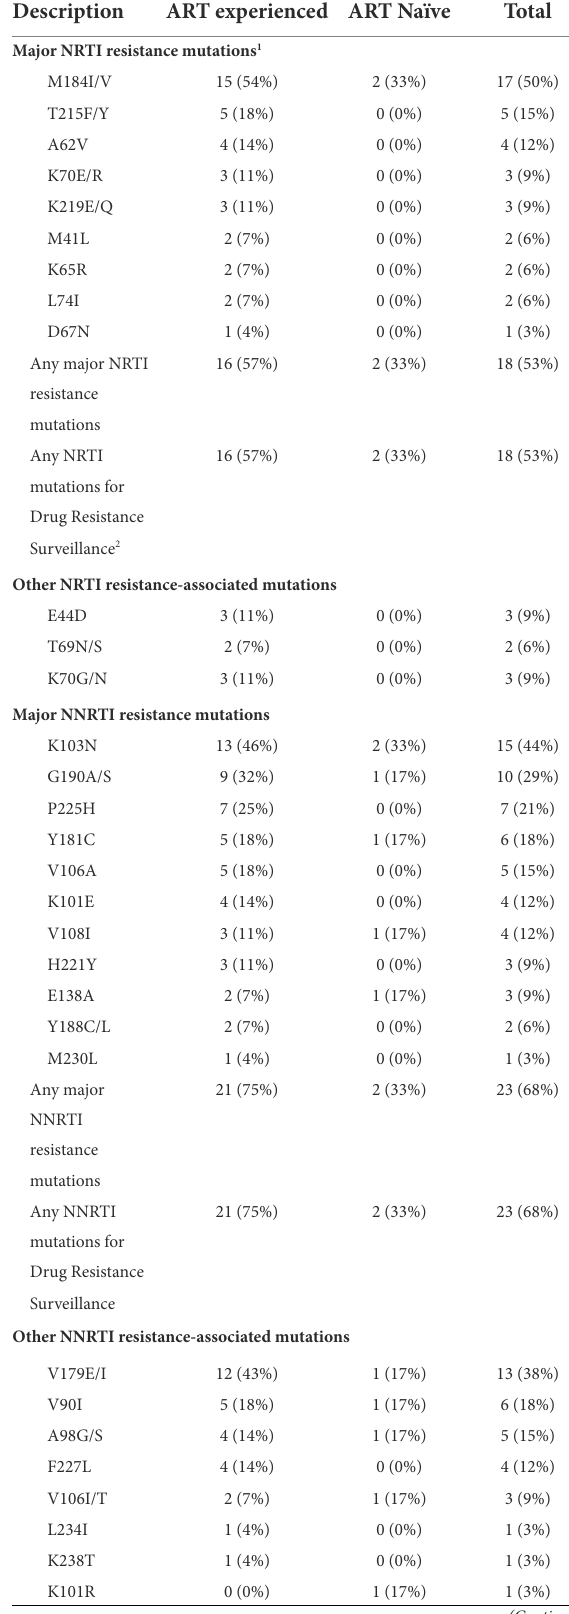
TABLE 2 Patterns of mutations detected in protease, reverse- transcriptase, and integrase regions of the HIV-1 polymerase